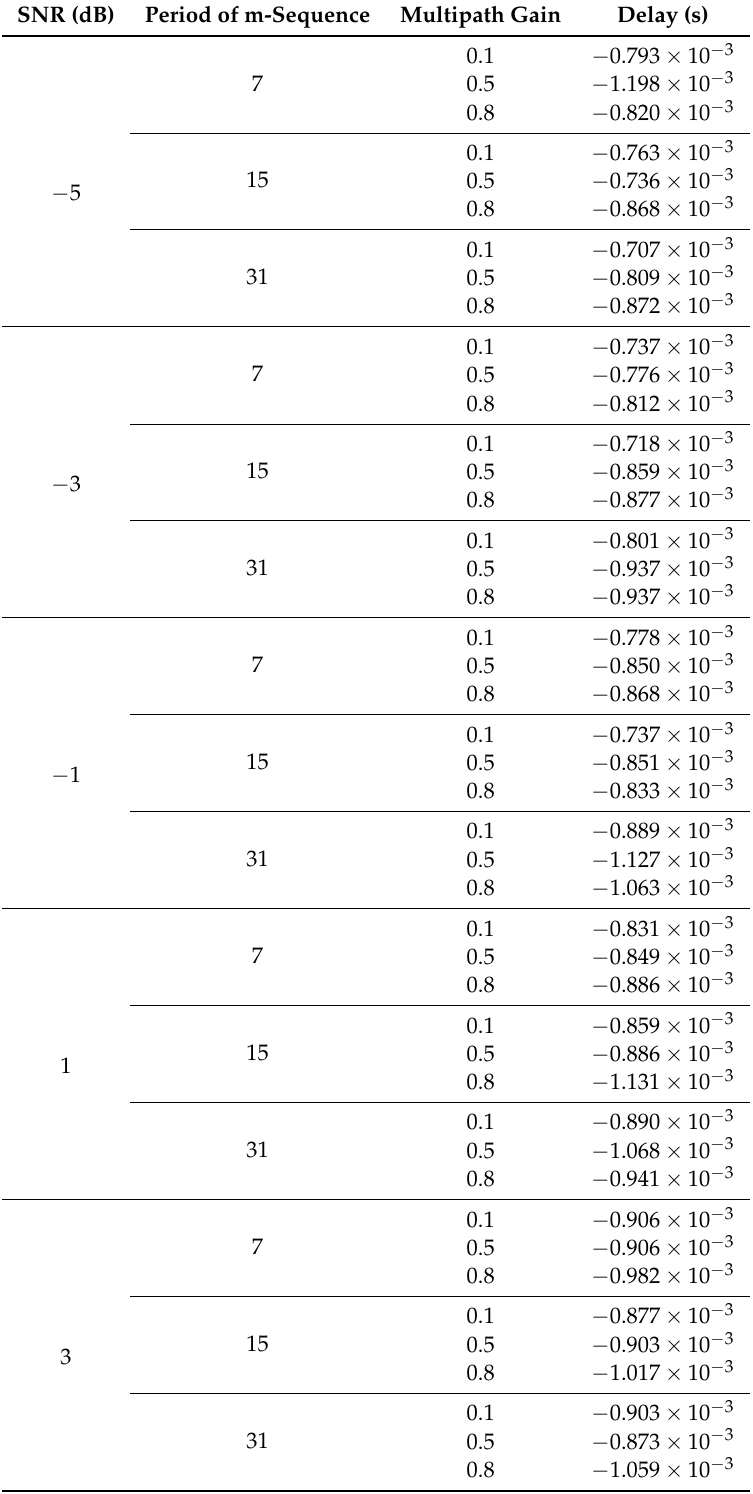
Table 2. Autocorrelation Scheme Delay Estimation with Multipath Gain